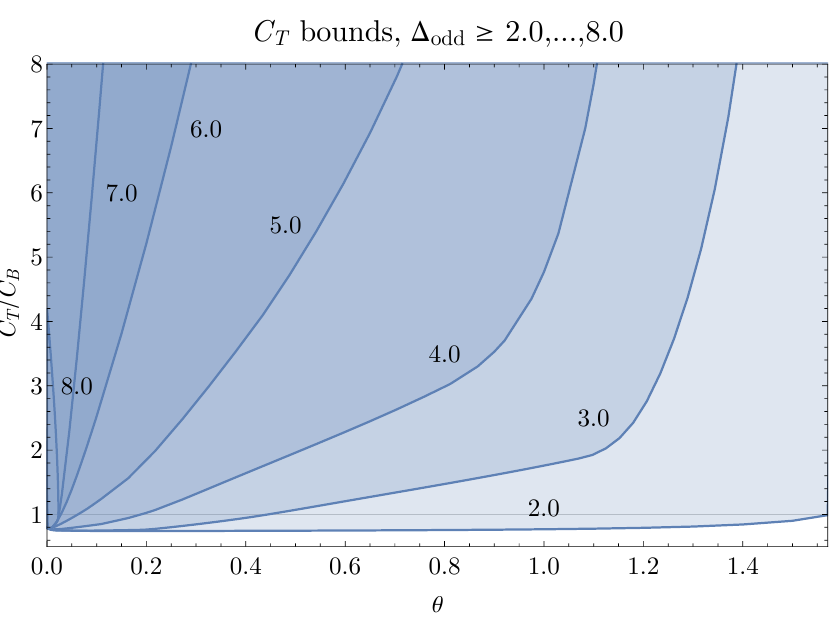
Figure 5 . Bounds on ( (cid:18); C T ) with varying gaps in the parity-odd scalar sector. When the value of the gap (cid:1) min > 7, it becomes possible to (cid:12)nd both upper and lower bounds on C T as. odd